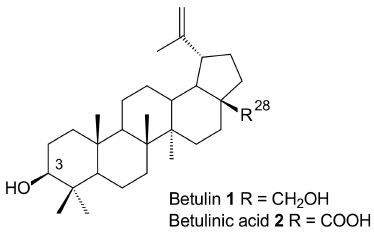
Figure 1. Chemical structures of betulin 1 and betulinic acid 2